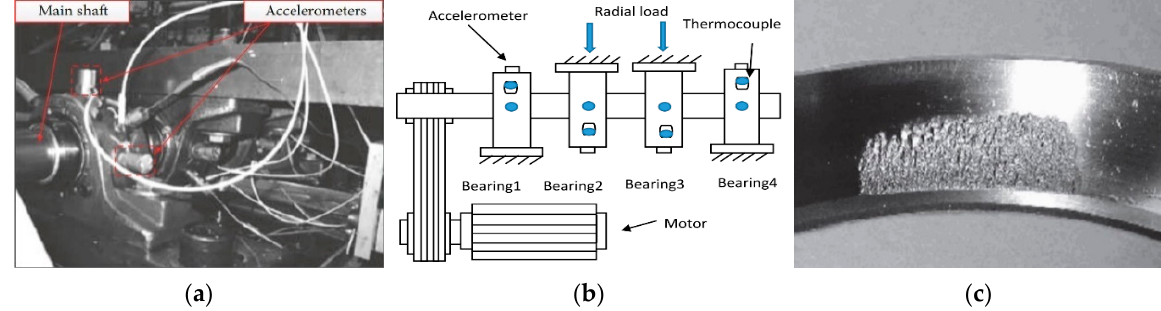
Figure 4. Illustration of the bearing experiment platform. ( a ) Bearing test rig; ( b ) sensor placement illustration; ( c ) outer race defect of set number 2.